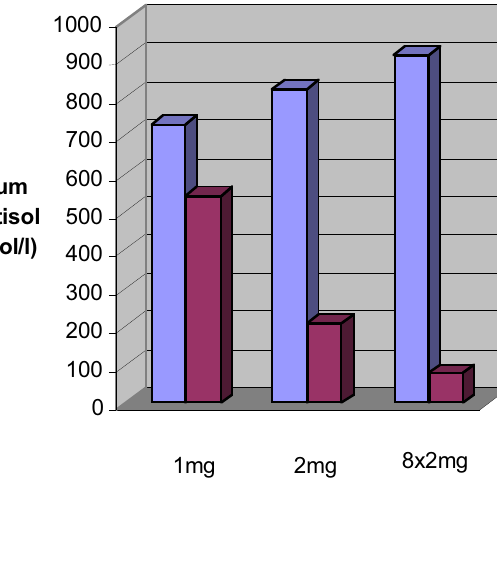
Dexamethasone suppression tests. Dexametha- sone was administered at midnight at a dose of 1 mg, 2 mg, and at a dose of 8 (cid:2) 2 mg within 2 days. Serum cortisol levels were measured 8 hours later. Even at 8 (cid:2) 2 mg of dexametha- sone, the serum cortisol was not inhibited when the patient was treated with phenytoin at a dosage of 3 (cid:2) 100 mg per